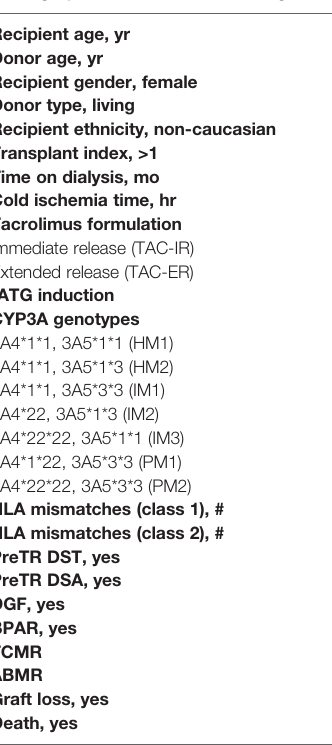
TABLE 1 | Main demographics of patients of the study. Demographical, clinical, Immunological